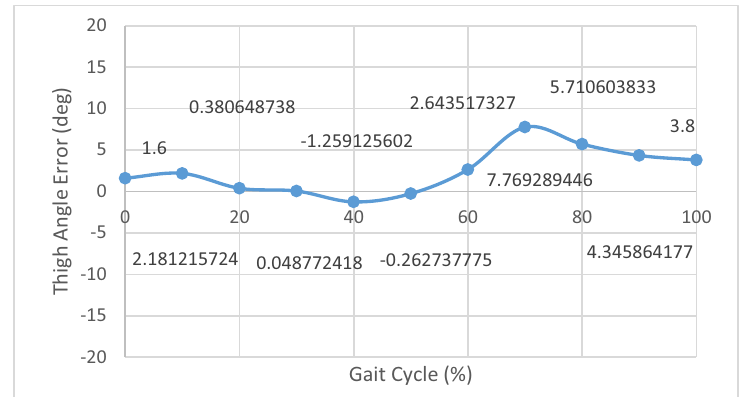
Figure 25: Error data of thigh angle simulation.